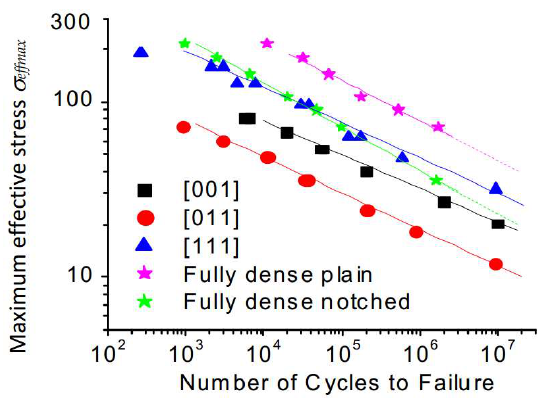
Figure 18. S-N representation of fatigue tests as a function of the effective stress evaluated with the minimum net cross sections.